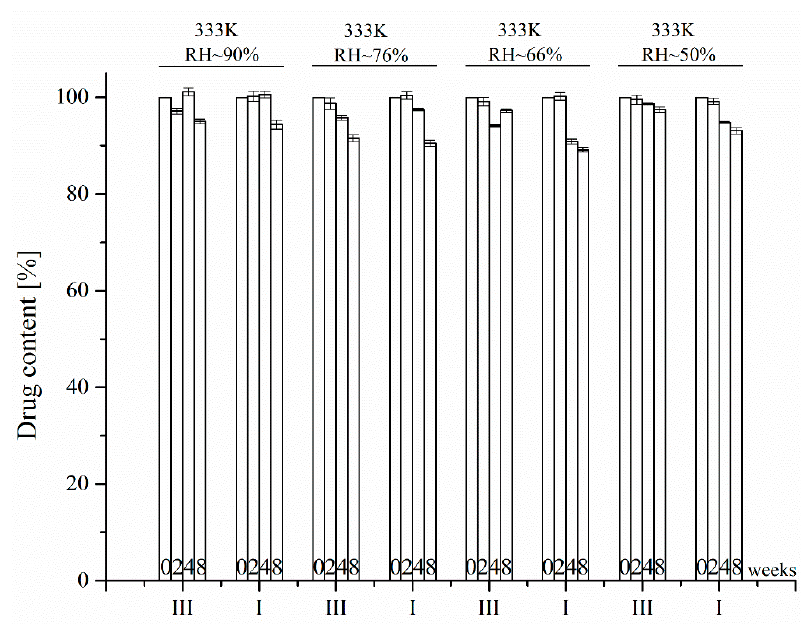
Figure 6. Benzocaine degradation results.